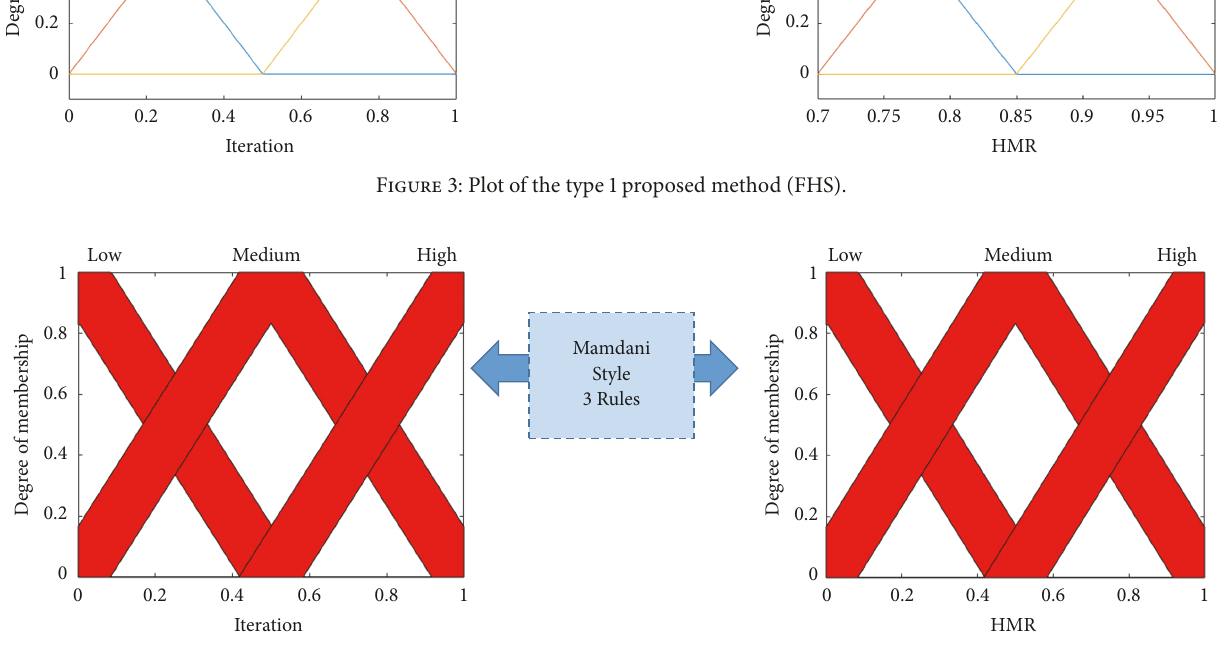
Figure 4: Plot of the interval type 2 proposed method (IT2FHS).